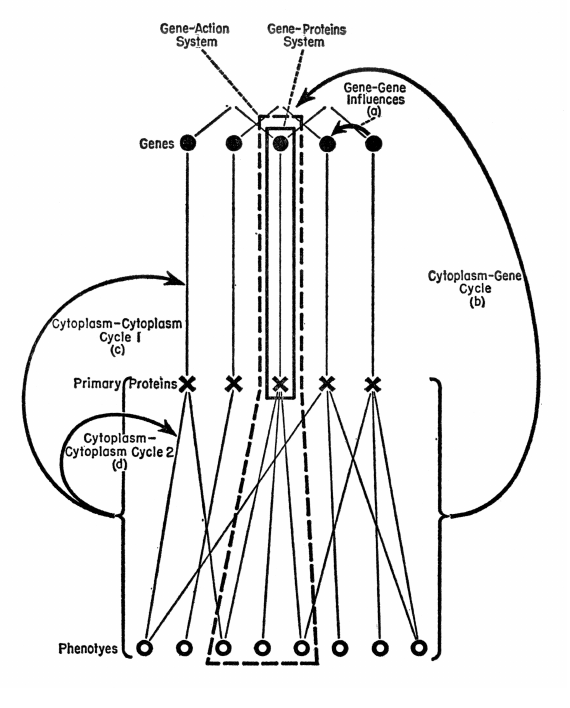
Epigenetic Action System of Cell , from Conrad H. Waddington , New Patterns in Genetics and Development (New York: Columbia University Press, 1962), 7 (photo: